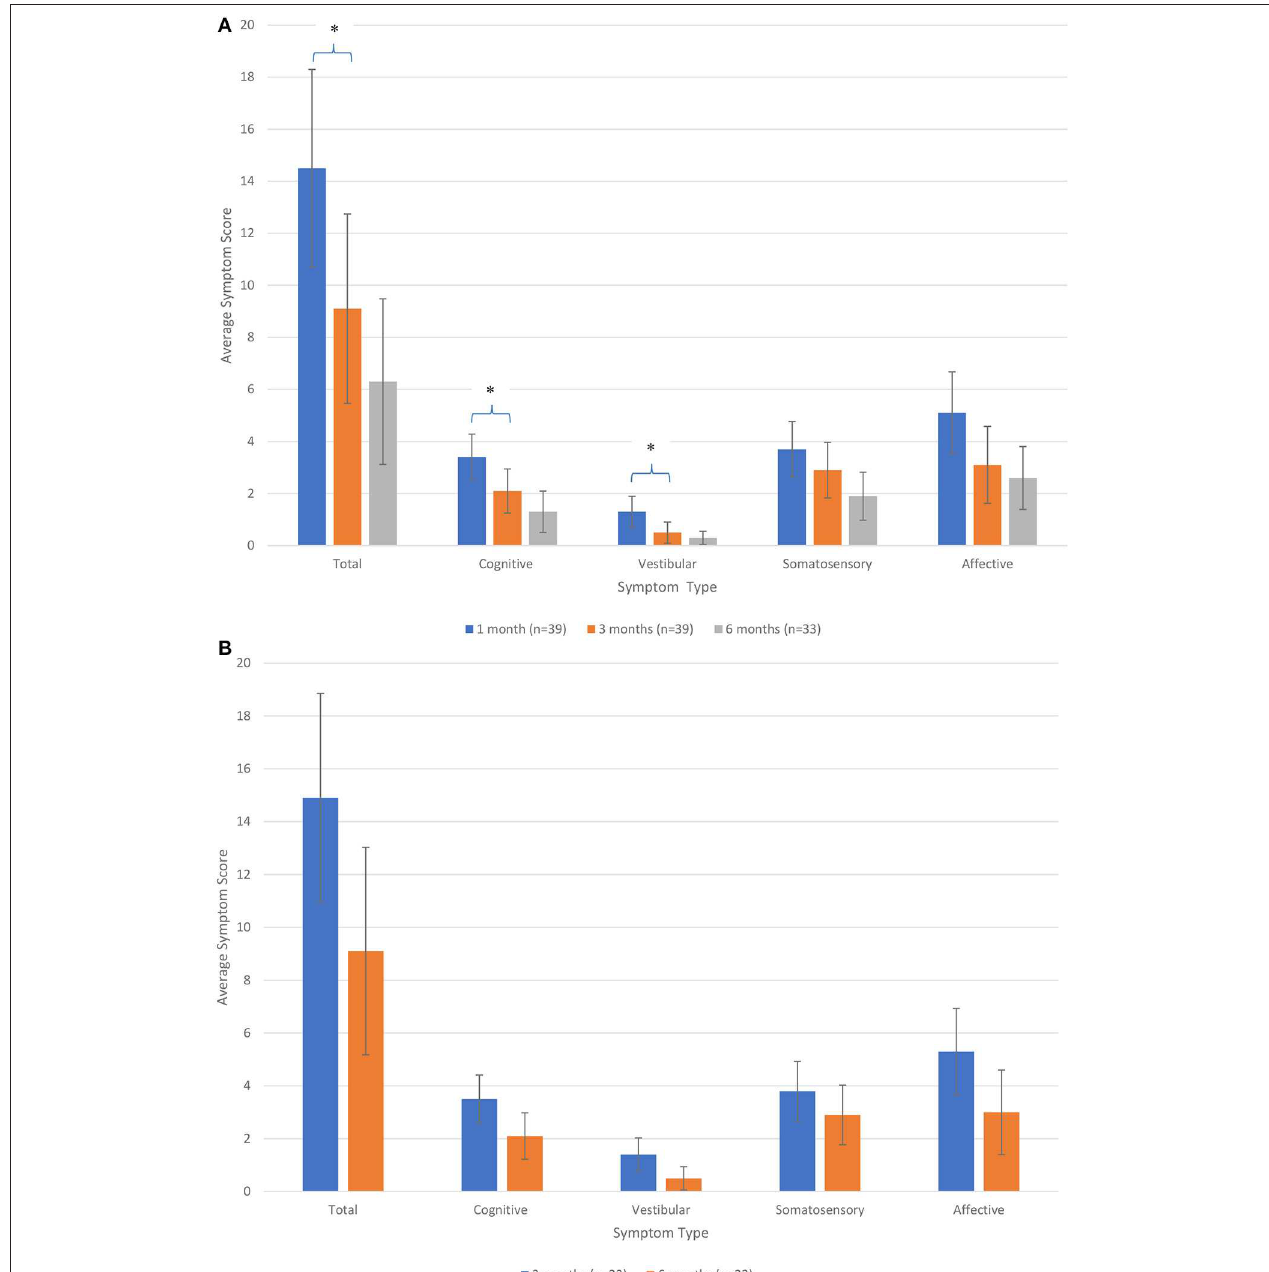
FIGURE 1 | (A) Average symptom level score over time (in total and by categories) for participants assessed for activity level at 1 month and symptom level at 3 months post-injury. *Significant at p < 0.05. (B) Average symptom level score over time (in total and by categories) for participants assessed for activity level at 3 months and symptom level at 6 months